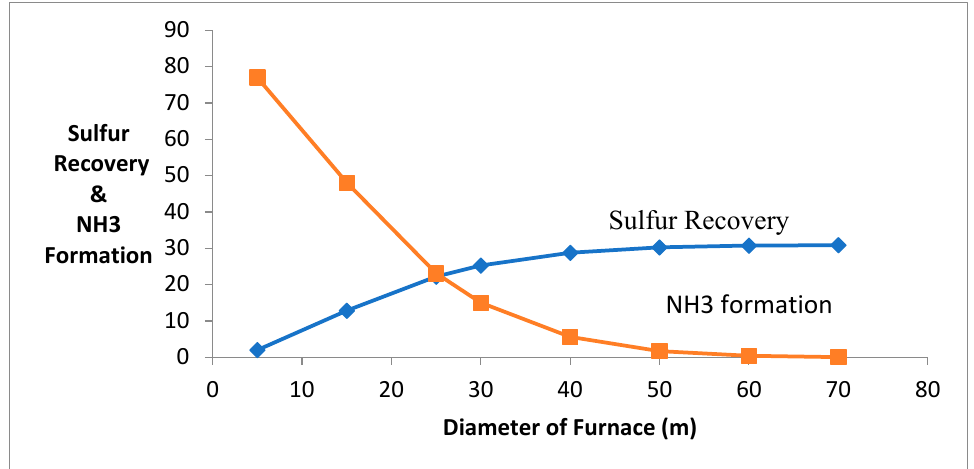
Figure 3. Effect of change in furnace diameter and length.